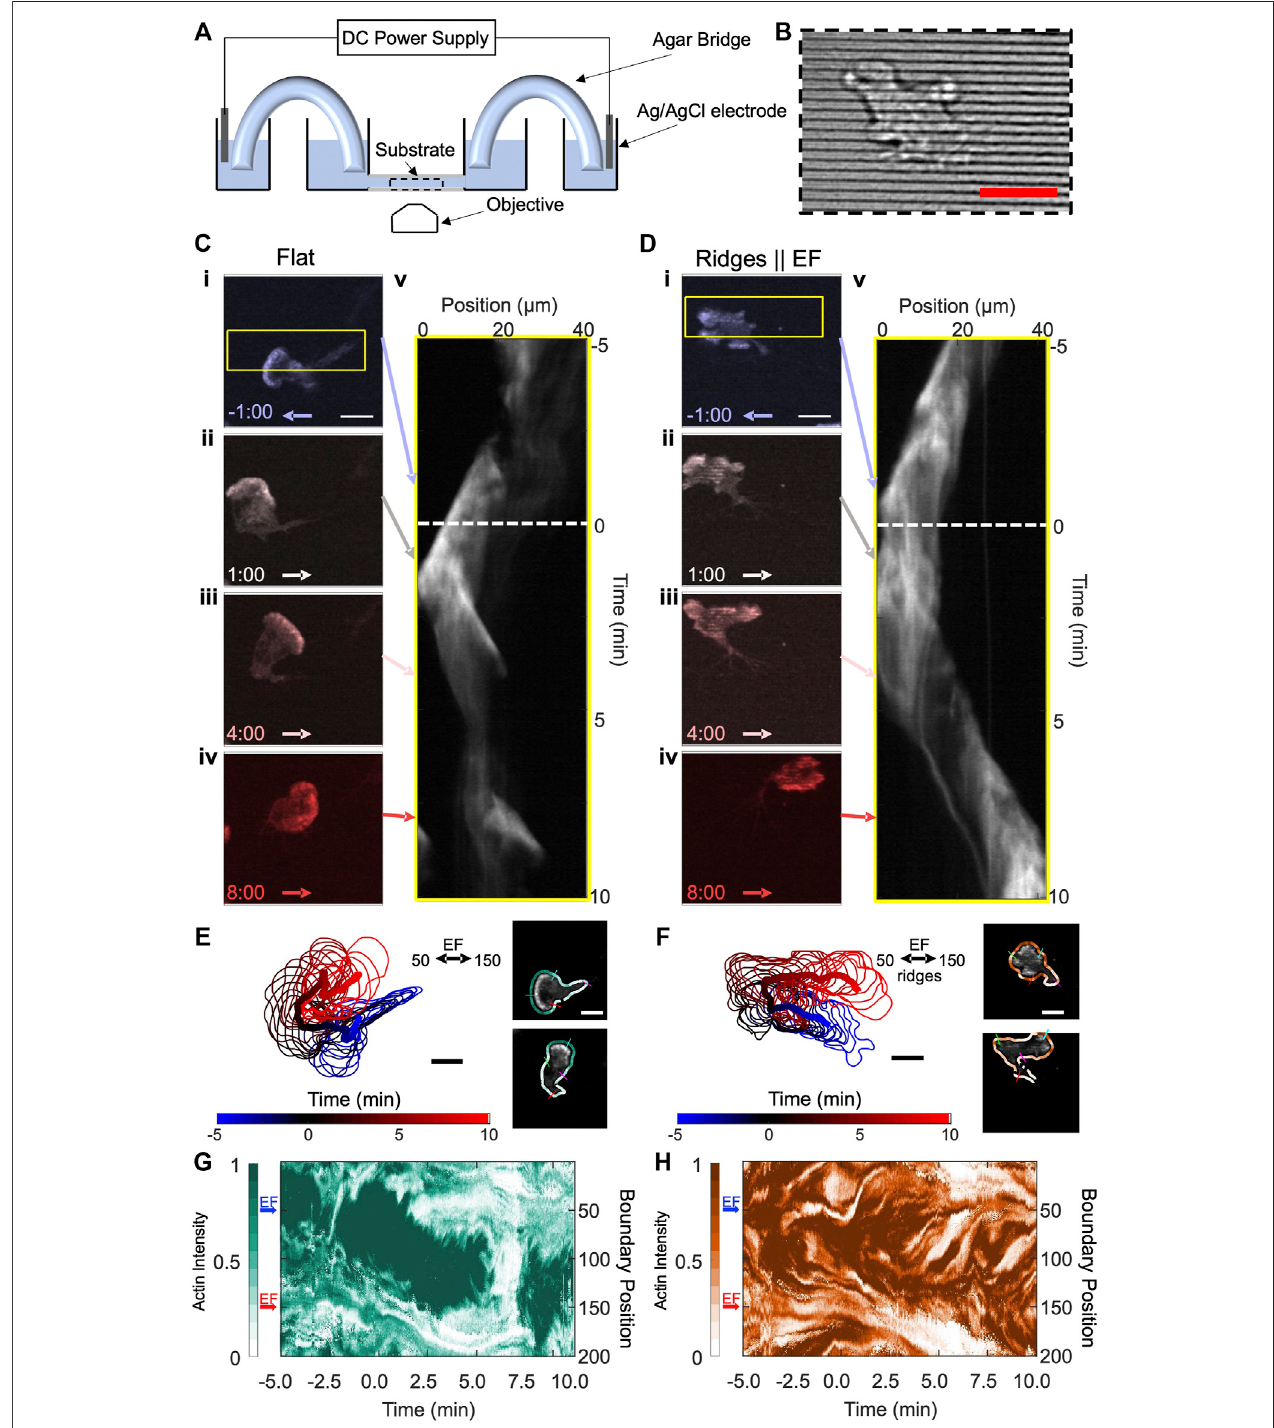
FIGURE 1 | HL60 cells turn toward the new cathode within several minutes of EF reversal on both fl at and nanoridged substrates, but with different local actin structures. (A) Schematicofthe agar/saltelectrotaxischamber. (B) Bright fi eldimageofresinnanoridges. (C) Fourtime-lapsesnapshotsofadifferentiated,YFP-actin- labelled HL60 cell on a fl at substrate. The cathodal (negative) direction is to the left at negative times. The EF reversal occurred at time zero. Kymograph (v) for area denoted by the yellow border in (i). (D) A differentiated, YFP-actin-labelled HL60 cell on nanoridges parallel to the EF. Kymograph (v) for the area denoted by the yellow border in (i). Scale bars are 10 µm. The arrows in (C,D) denote the EF direction, and the corresponding time slices in the actin intensity kymographs. (E – F) Boundary shape and path of the centroid of cell from (C,D) from − 5:00 min to 10:00 min in 0.5-min increments, with an example of the extracted shape of a cell with